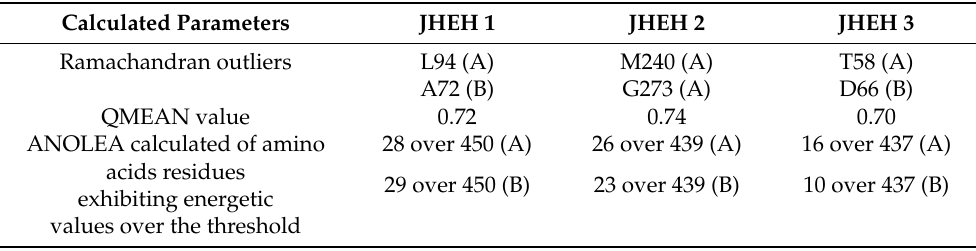
Table 1. Geometric and thermodynamic quality of the three-dimensional models built for JHEH 1, 2 and 3 homodimers (A + B